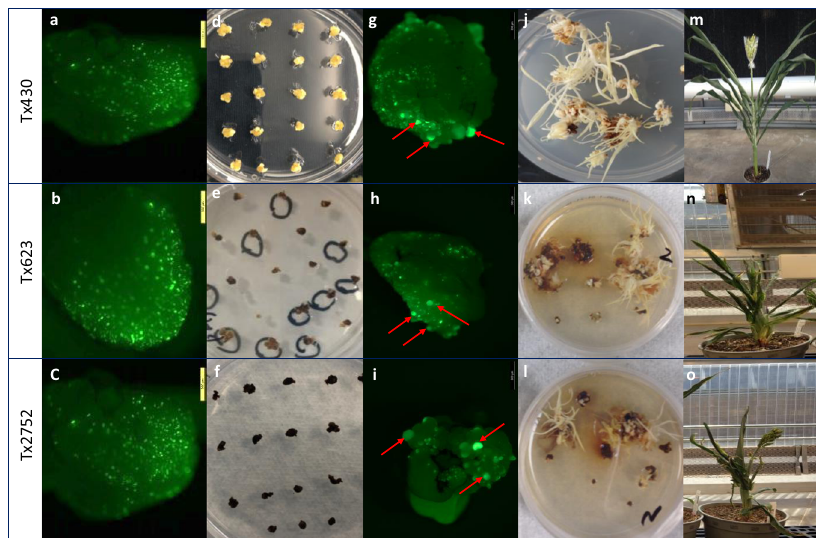
Fig. 1 Characterization of sorghum transformation. a – c Gene delivery capacity of ternary transformation system. Gene delivery was represented by the number of transgenic cells exhibiting YFP fl uorescence on the surface of sorghum embryos. d – f Tissue culture response represented by callus proliferation after two weeks of Agrobacterium infection on the multi-purpose medium without selection. g – i YFP images of early-stage somatic embryo formation (indicated by the arrows) induced by morphogenic gene expression on the surface of immature scutella. j – l Shoot regeneration after four-week of maturation. m – o The pleiotropic impacts of morphogenic gene expression on single-copy QEs. a , d , g , j and m Tx430. b , e , h , k , and n Tx623. c , f , i , l and o